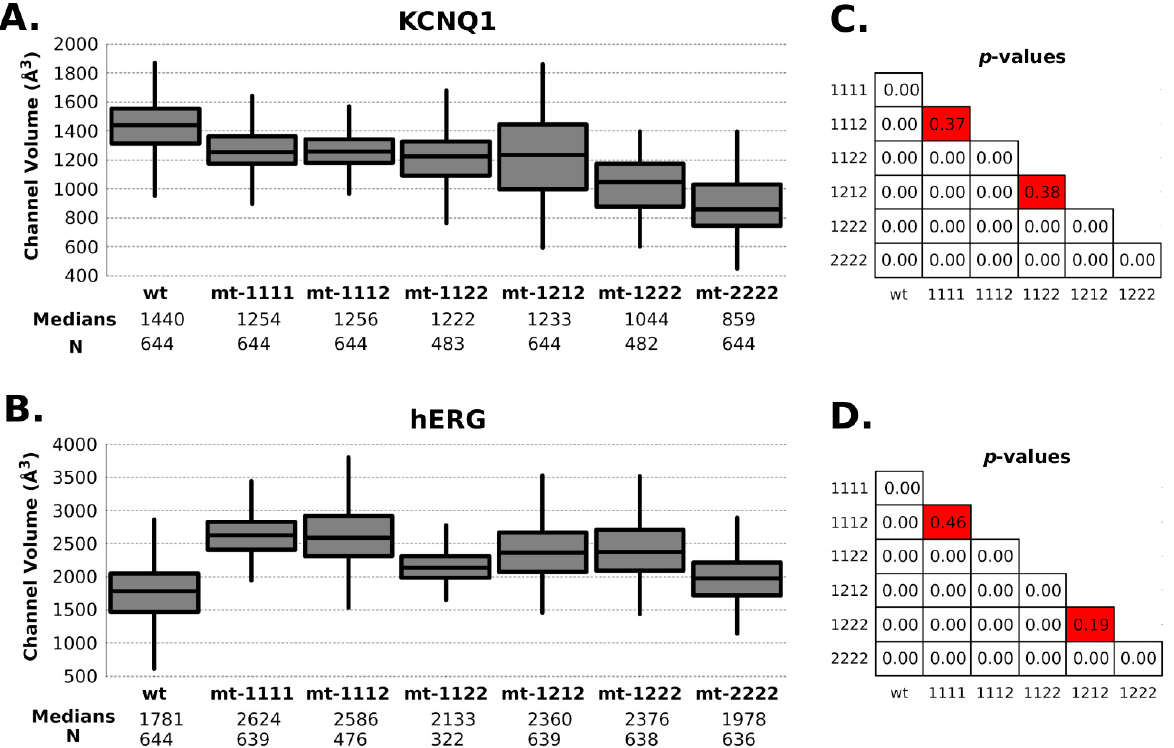
Figure 6. Channel volume. Box plots show the distribution of channel volume values calculated from molecular dynamics ( A ) KCNQ1 channel and ( B ). hERG channel. Panels ( C ). (KCNQ1) and ( D ). (hERG) show the Welsh t-test p-values between each data series. Boxes in red show nonsignificant differences between distributions. The time interval between each volume data is 0.5 nanoseconds.